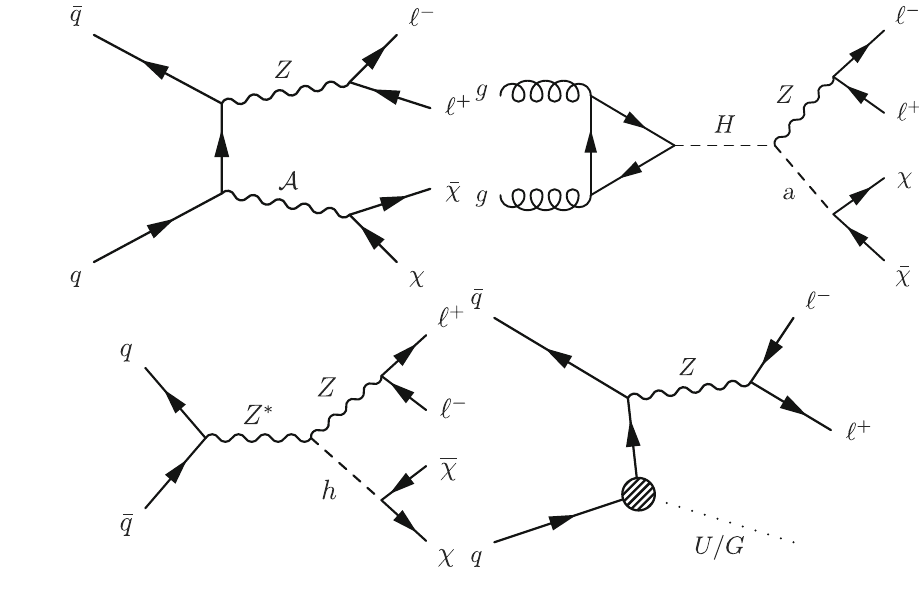
illustrative of the BSM processes that produce a final state of a Z boson that decays into a pair of leptons and missing transverse momentum: (upper left) simplified dark matter model for a spin-1 mediator, (upper right) 2HDM+ a model, (lower left) invisible Higgs boson decays, and (lower right) graviton (G) production in a model with large extra dimensions or unparticle ( U ) production. Here A represents the DM mediator, χ represents a DM particle, while (H, h) and a represent the scalar and pseudoscalar Higgs bosons, respectively. Here h is identified with the 125GeV scalar boson. The dotted line represents either an unparticle or a